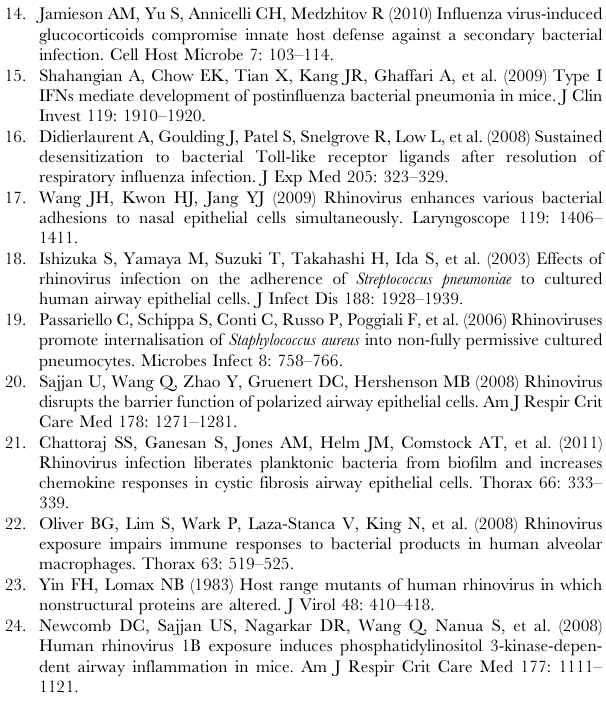
Figure S2 RV induced reduction in IRAK-1 protein is not IL- 1 b -dependent. BEAS-2B cells were infected with sham or RV39